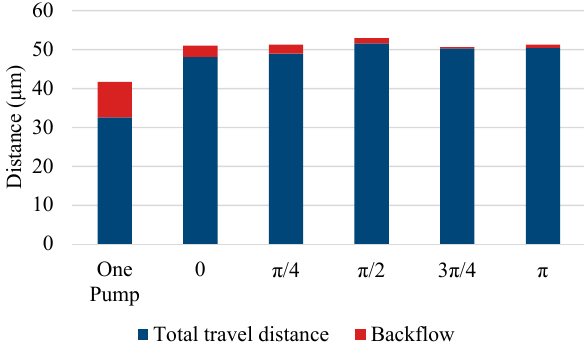
Figure 10. Forward flows and backflows of a series pump.